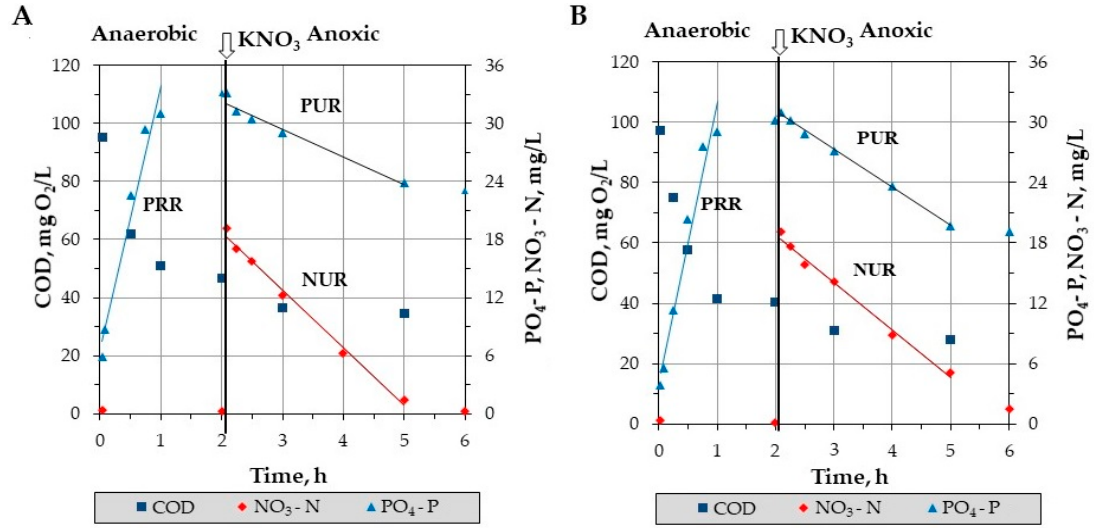
Figure 3. Sample of concentration changes during the two-phase test ( A ) wastewater after 2-h sedimentation without dosing of coagulants, ( B ) wastewater after 2-h sedimentation preceded by 3F Chimica dosing. Table 2. Average nitrogen and phosphorus removal rates obtained using activated sludge samples from analyzed WWTPs and supernatant after 2-h sedimentation without and with addition of coagulant.